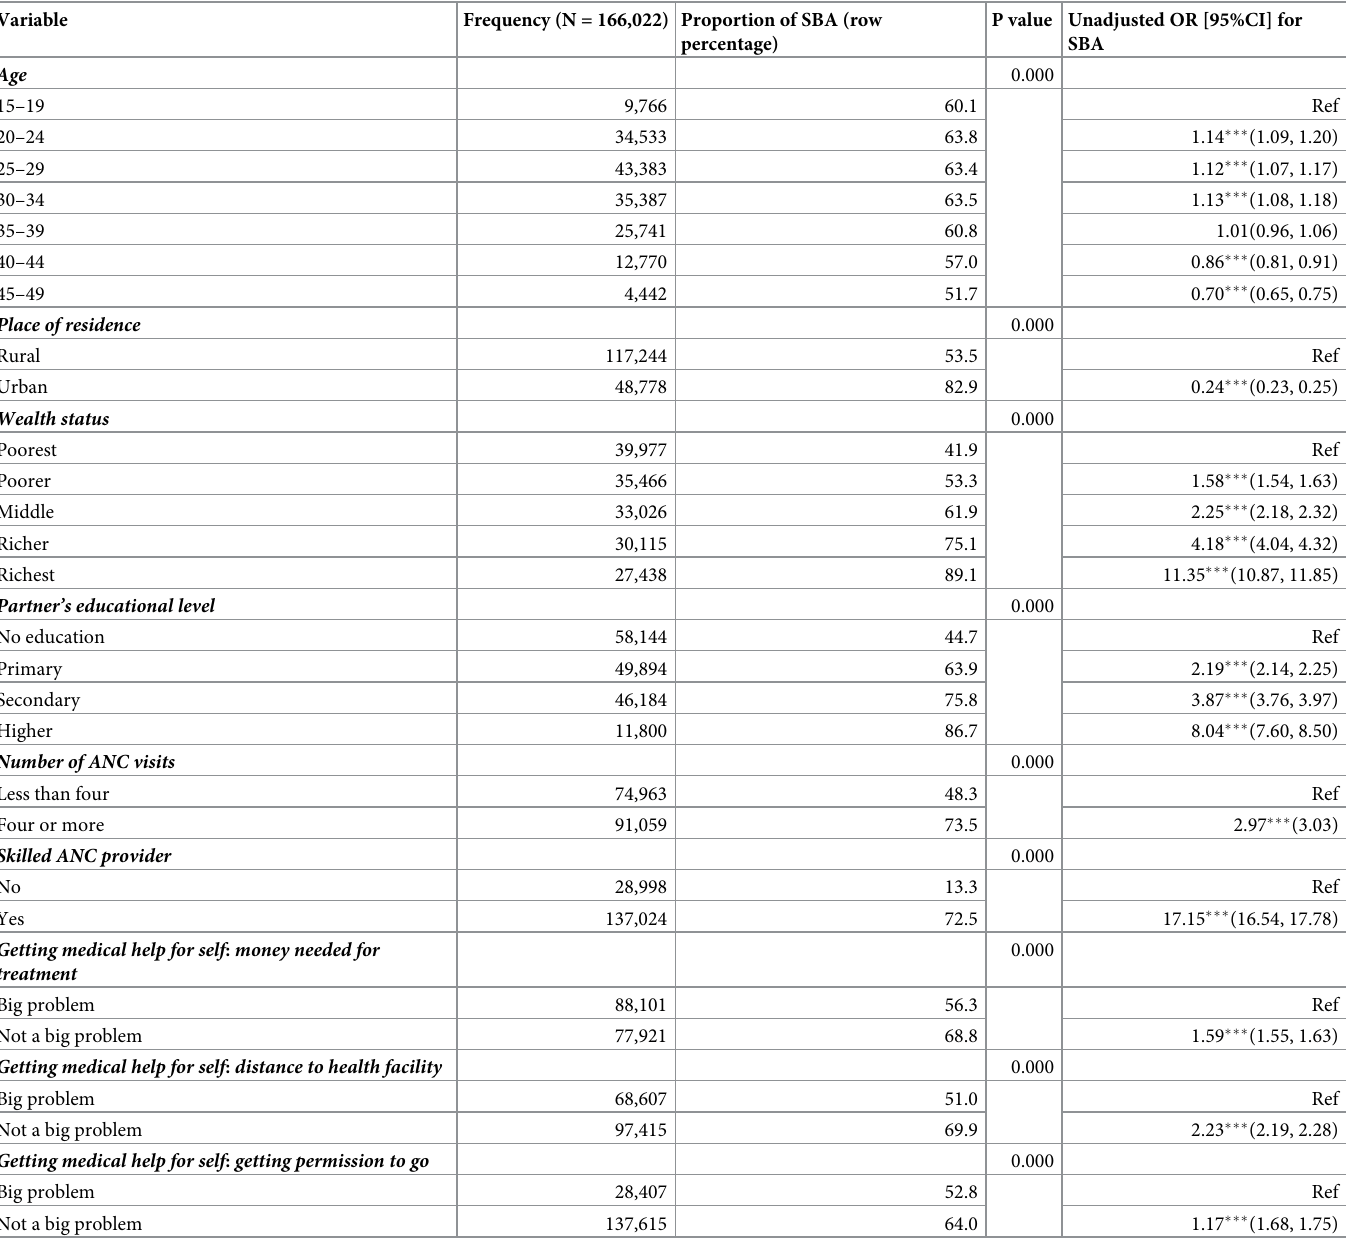
Table 2. SBA practices according to the background characteristics of participants. Variable Frequency (N = 166,022) Proportion of SBA (row